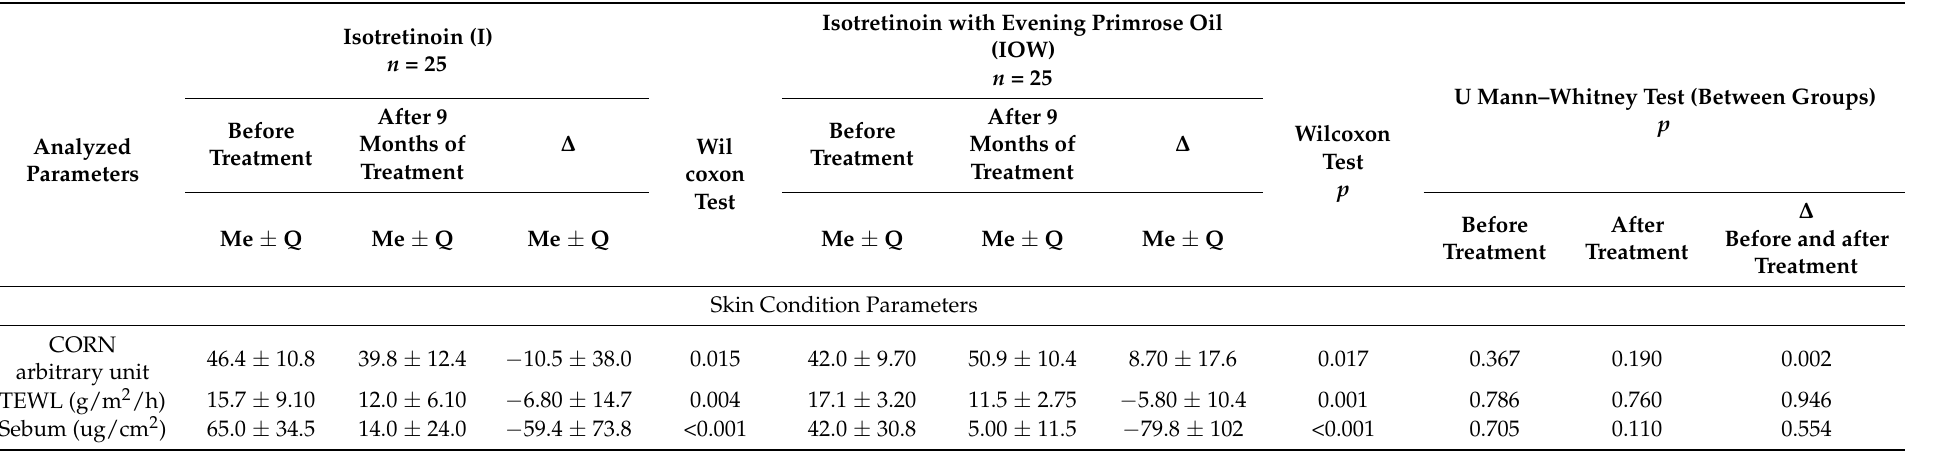
Table 3. Changes in CORN, TEWL and sebum levels before and after the